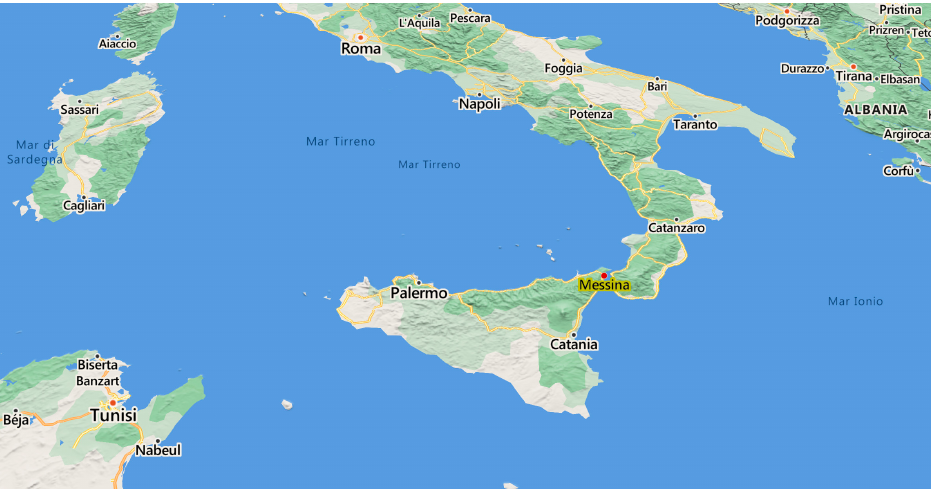
Figure 1. The city of Messina, in Sicily.